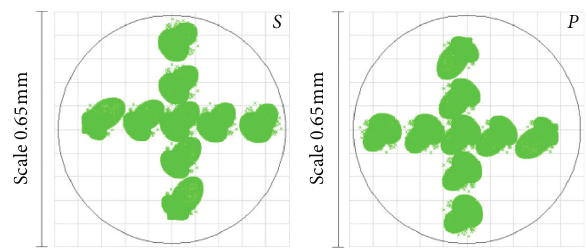
Figure 6: Theoretical spot diagram. The 1620nm spectral channel for ( o ) ( S ) and ( e ) ( P ) light components.